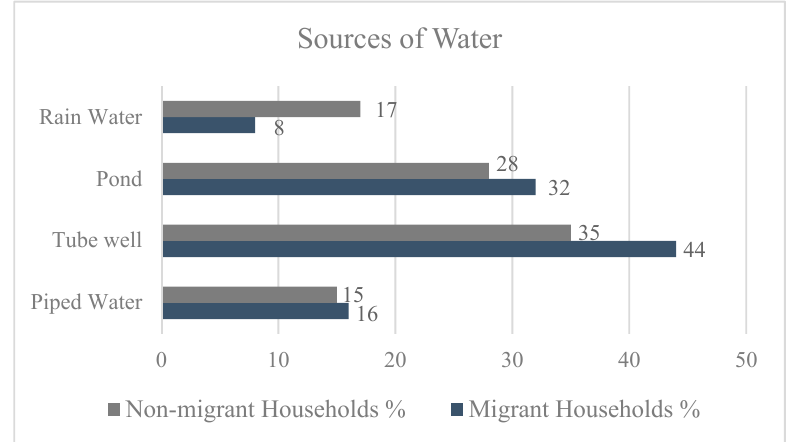
Figure 3. Sources of water.